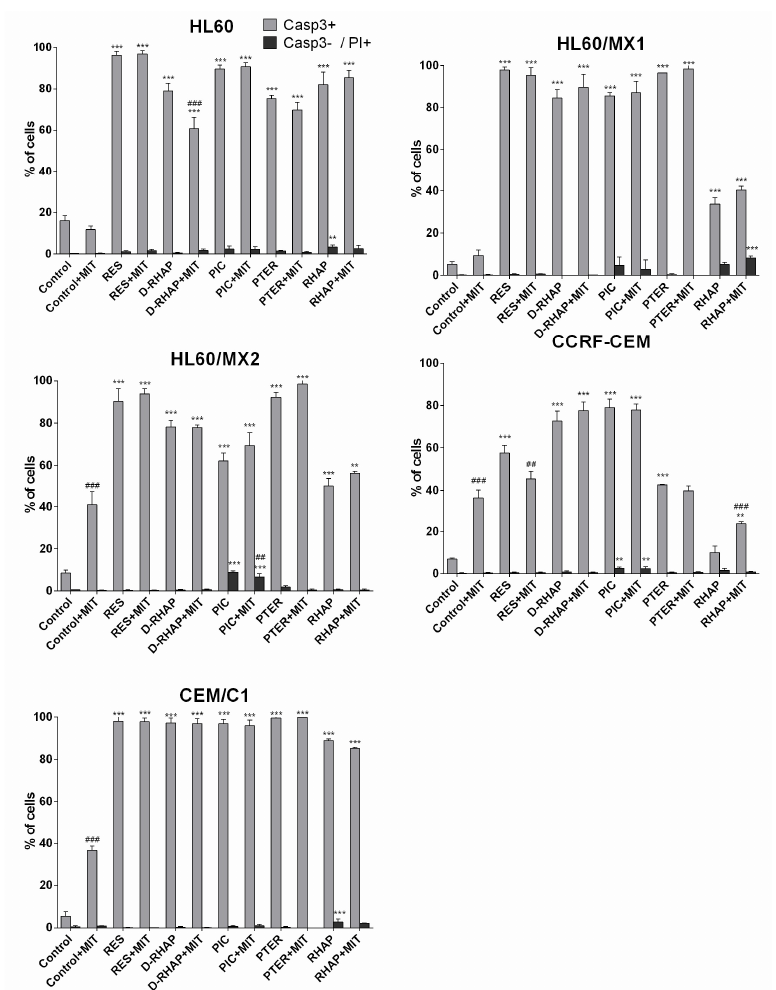
Figure 6. Apoptosis analysis using PhiPhiLux-G 1 D 2 -FITC and propidium iodide on cell lines treated